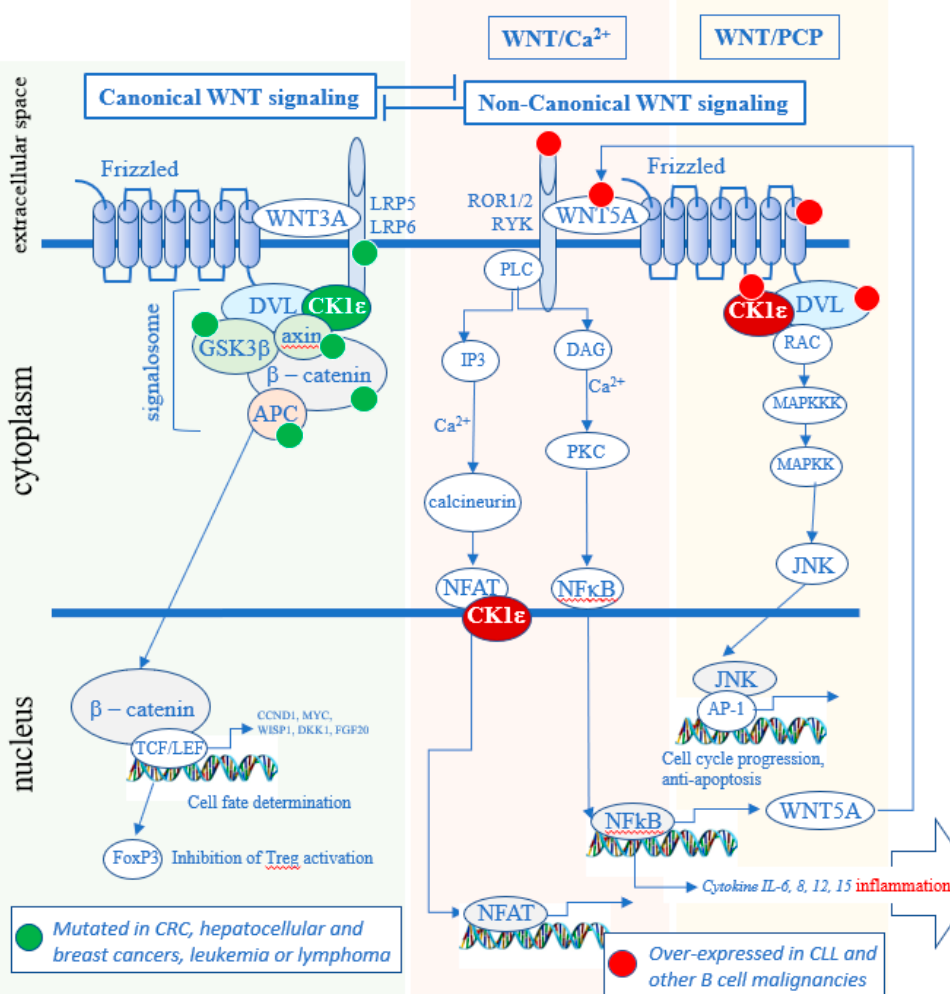
Figure 2. Role of CK1 δ / ε in the Wnt signaling pathways. In the canonical pathway, it maintains the signalosome active and blocks the degradation of β -catenin. In the non-canonical pathway, CK1 δ / ε kinase activity leads to the activation of the Wnt / Ca2 + and Wnt / PCP pathways. Many oncogenic mutations in the canonical pathway are found in solid tumors (green dots) [23–27], whereas many over-expressions of oncogenes are present in hematologic cancers (red dots) [28–32]. CRC—colorectal cancer.